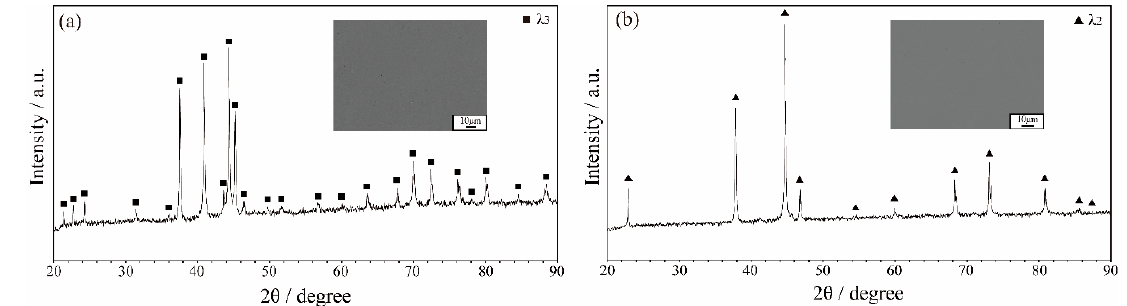
Figure 3. X-ray diffraction patterns obtained from ( a ) the Co 44 Re 14 Ta 42 alloy annealed at 1200 °C for 35 days, ( b ) the Co 31 Re 35 Ta 34 alloy annealed at 1300 °C for 25 days, ( c ) the Co 58 Re 3 Ta 39 alloy annealed at 1200 °C for 35 days, and ( d ) the Co 60 Re 1 Ta 39 alloy annealed at 1300 °C for 15 days.